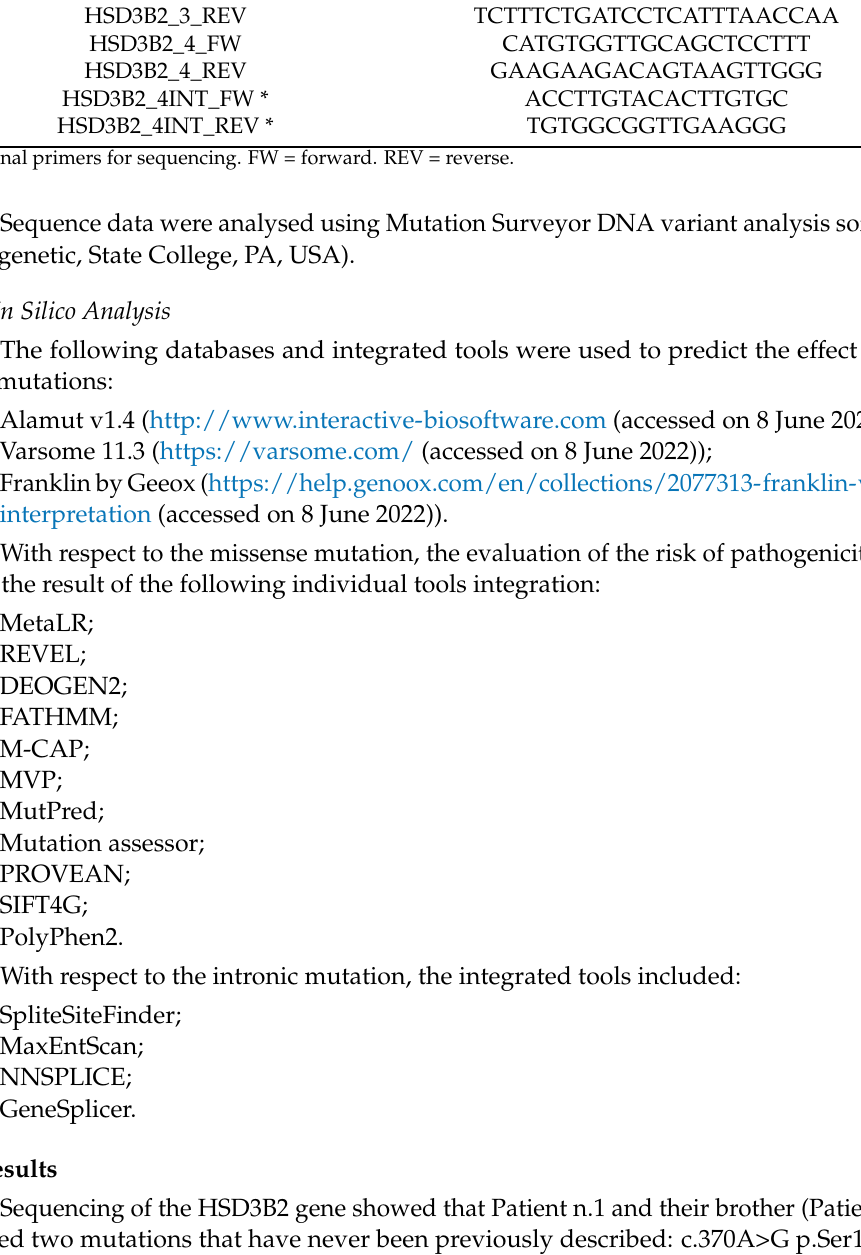
Table 2. Oligonucleotides designed for the HSD3B2 mutation analysis. Primer Sequence